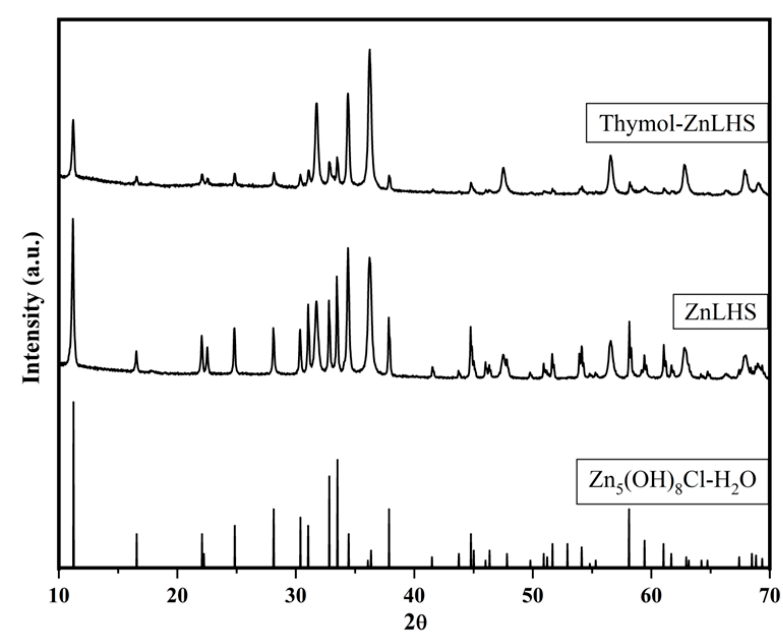
Figure 1. X-ray diffractograms of zinc layered hydroxide with and without thymol.